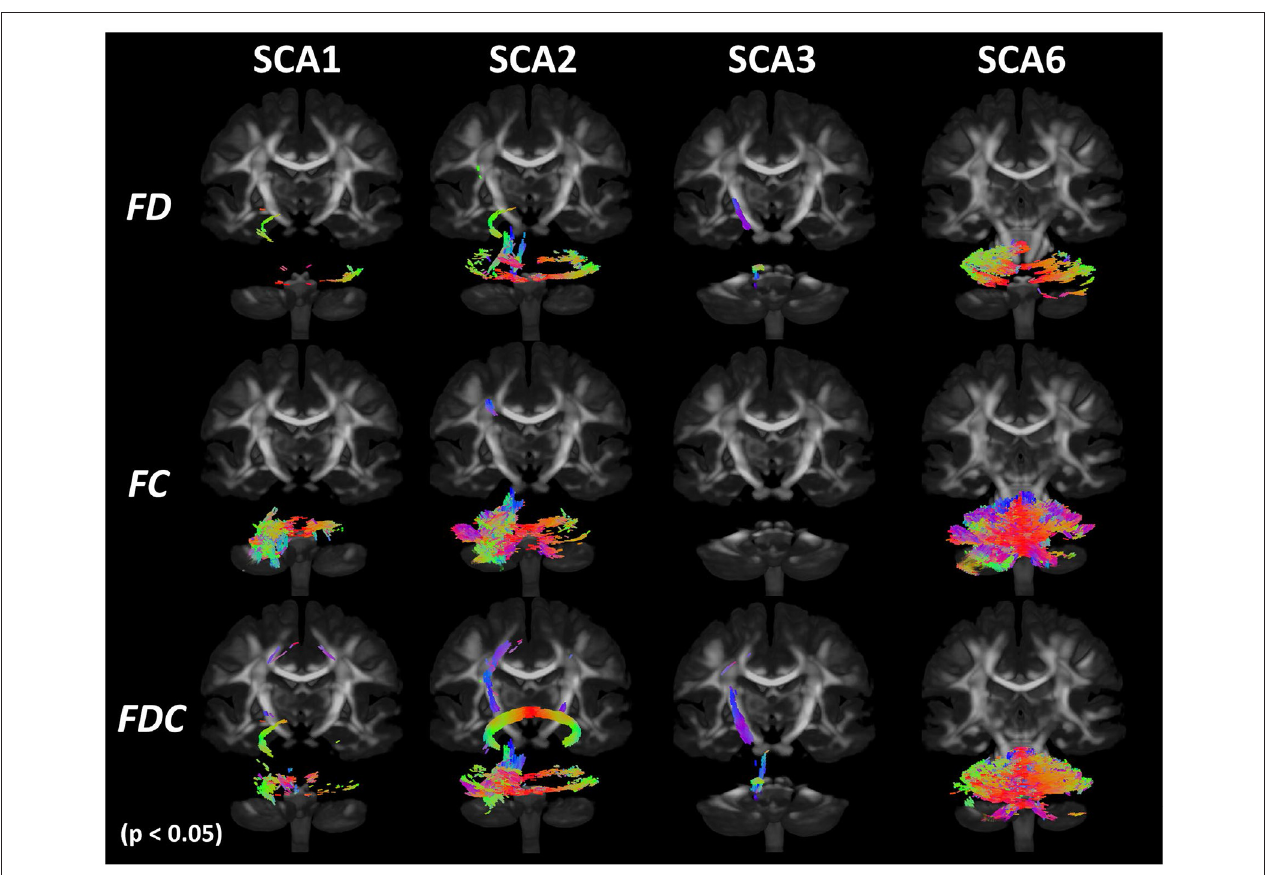
FIGURE 5 | Results of fixel-based analysis (FBA). FBA analysis shows significant ( p < 0.05 with family-wise error correction) cross-sectional differences between patients with SCAs and healthy controls for SCA1, 2, 3, and 6 in fiber density (FD), fiber crossing (FC), and FDC metrics. Colors indicate direction of the white matter fibers with blue indicating superior–inferior direction; red indicating left–right direction; and green indicating anterior–posterior